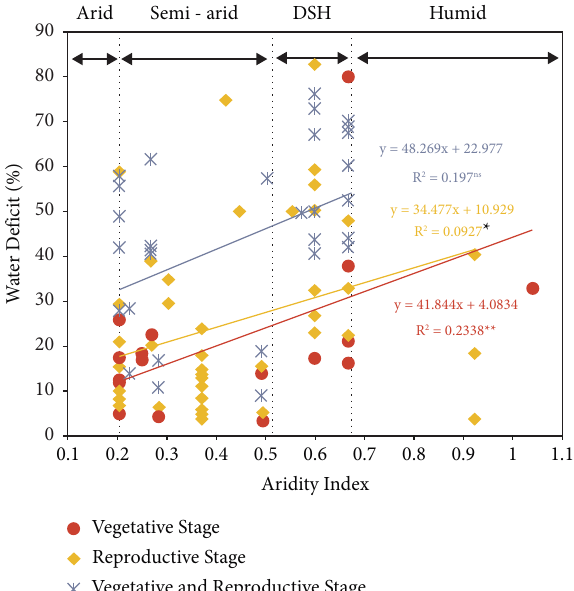
Figure 5: Regression of water defcit levels in relation to the aridity index. DSH: dry-sub-humid